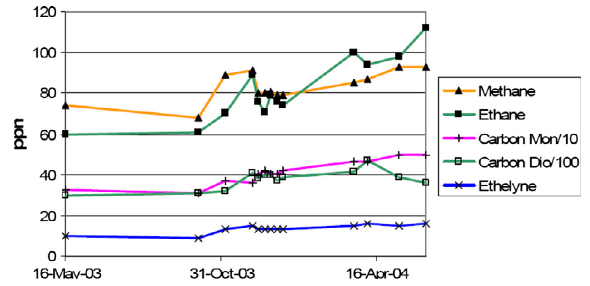
Fig. 4. DGA record of generator step-up transformer showing gassing starting end